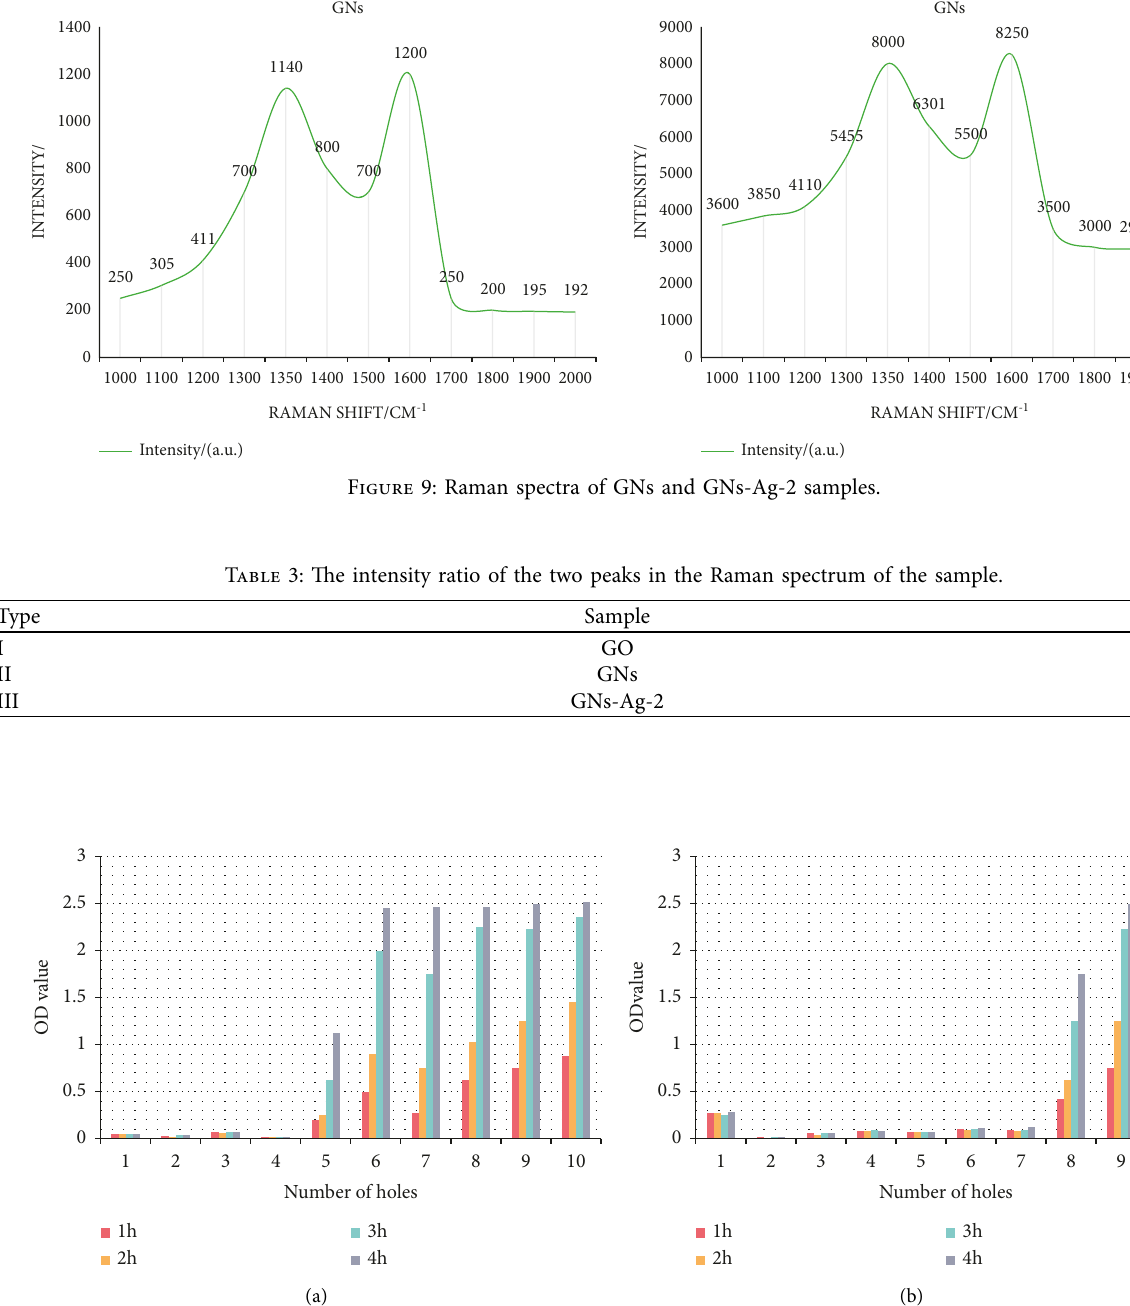
Figure 10: The effect of Ag/rGO composites on the light absorption value of fungi at different